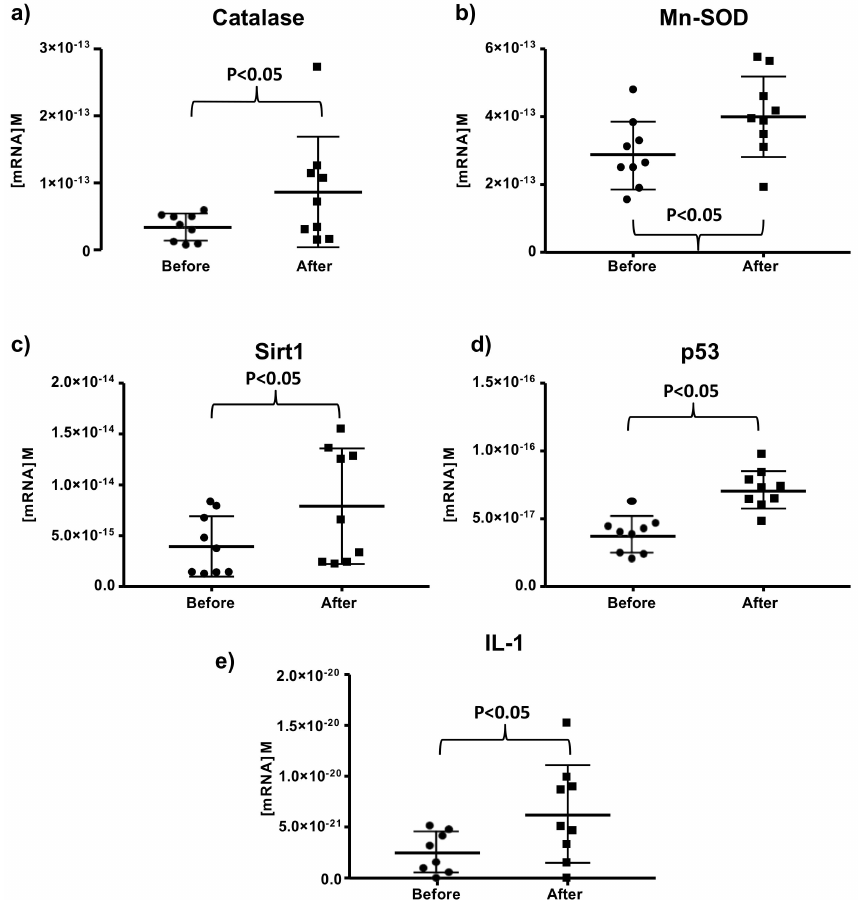
Figure 1. Moderate consumption of red wine increases catalase ( a ) MnSOD, ( b ), Sirt1, ( c ) p53, ( d ) and IL-1, ( e ) mRNA concentration in mononuclear cells. The concentration was measured by “sequenom quantitative gene expression (QGE) analysis”. Data are expressed as median and range with 95% CI for 9 different people, before starting the treatment and two weeks after a daily consumption of two glasses of red wine (200 mL, each), one at lunch and the other one at